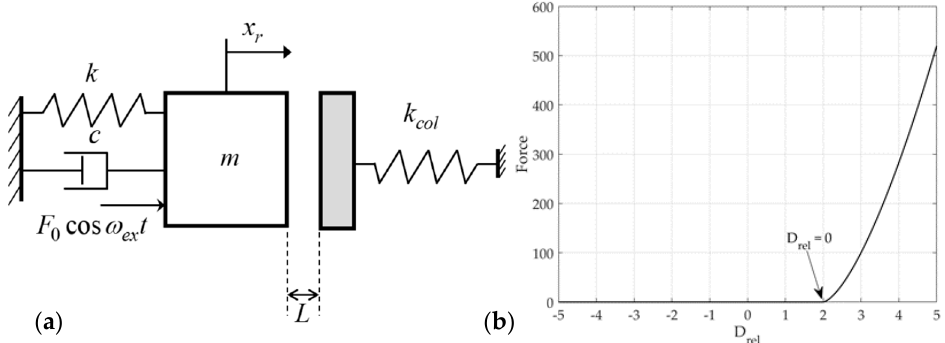
Figure 1. Rattle model: ( a ) 1-D model; ( b ) impact force. The single-mode squeak model is excited with the same amplitude f 0 and excitation frequency ω ex as the rattle model shown in Figure 2a. On the contact surface, a frictional force is generated by the normal force and the relative velocity. The friction force includes the creep region and negative slope for the sliding speed from Coulomb’s law of friction, as shown in Figure 2b. The multi-mode squeak model has an added mass m 1 , spring stiffness k 1 , and coefficient of viscous damping c 1 , and the frictional force generated by each mass is the same as that of the single-mode squeak model, as shown in Figure 3.